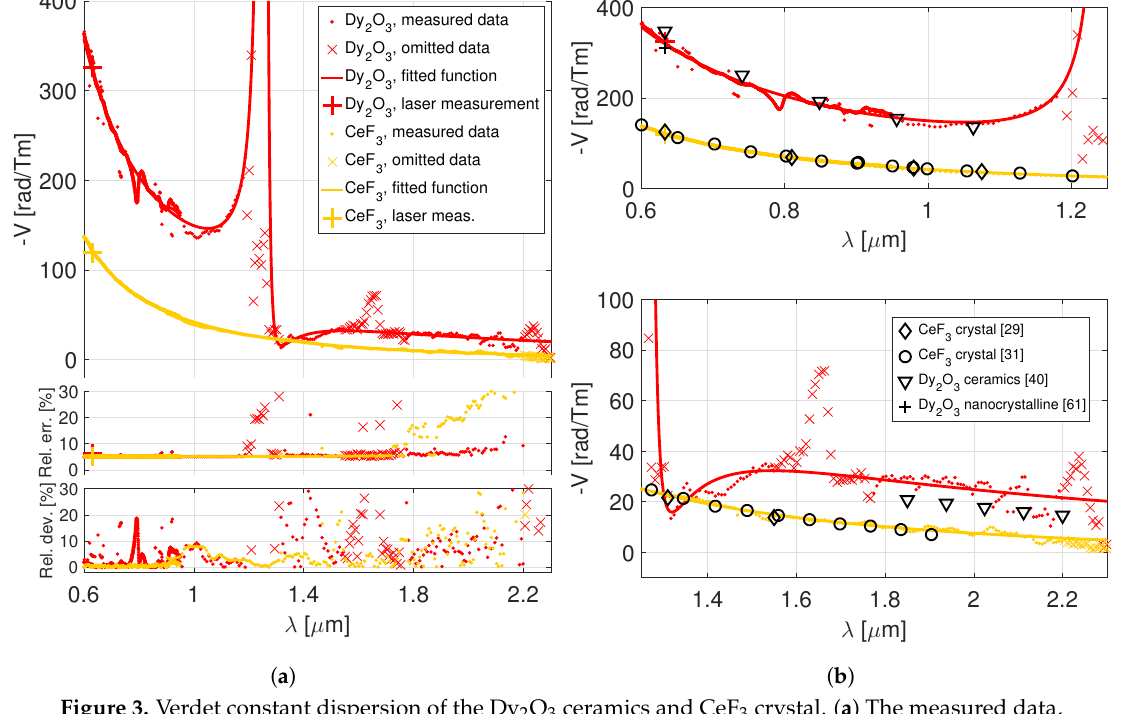
Figure 3. Verdet constant dispersion of the Dy 2 O 3 ceramics and CeF 3 crystal. ( a ) The measured data, omitted data for the fit, fitted models (the top-most plot). Relative errors of the measurement, relative deviations of the data from the fitted models (the two bottom-most plots). ( b ) Comparison with the Verdet constant values that may be found in the available literature. Table 3. Obtained fitting parameters of the Verdet constant dispersion model (7) (for the Dy 2 O 3 ceramics) and of the model (6) (for the CeF 3